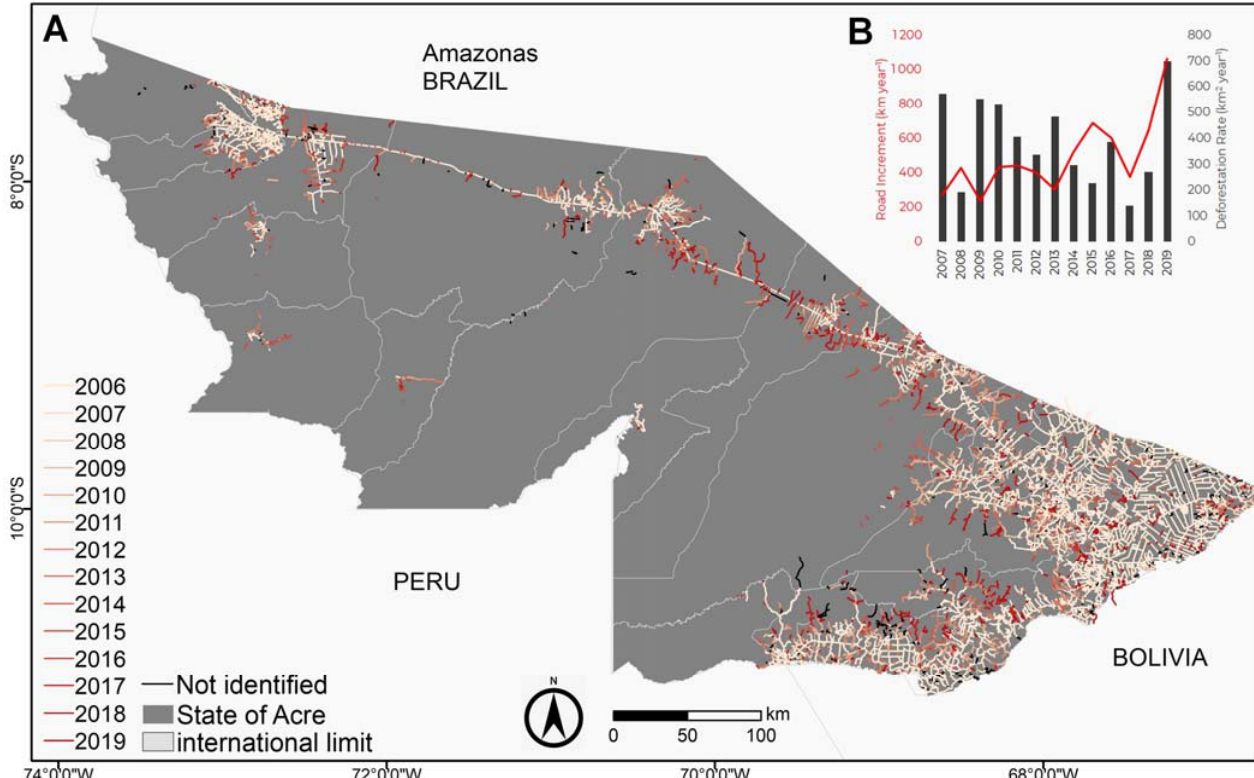
Figure 3. ( A ) Spatial–temporal distribution of roads in the State of Acre. ( B ) Annual increment of roads and deforestation in the State of Acre from 2007 to